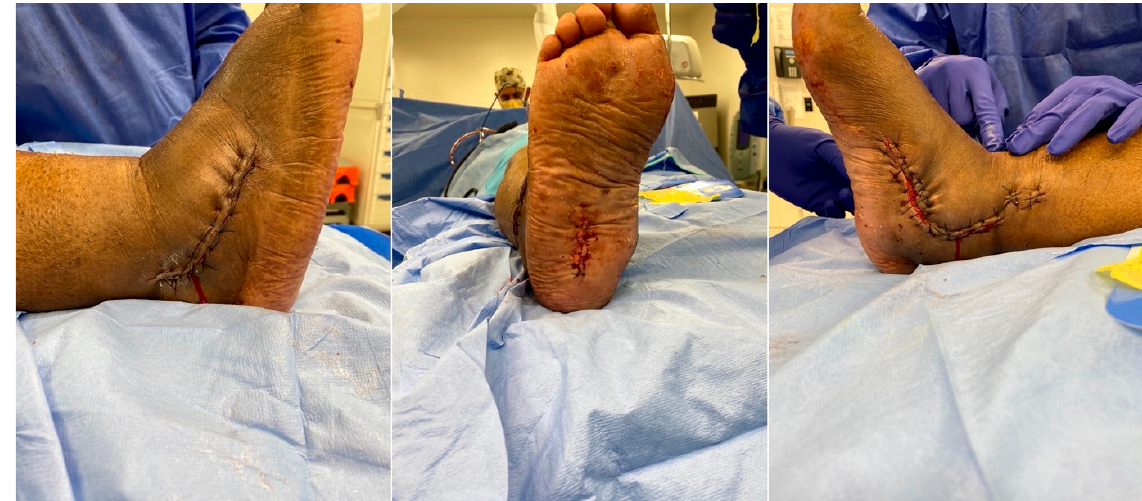
Figure 8. Intraoperative clinical images after fixation.